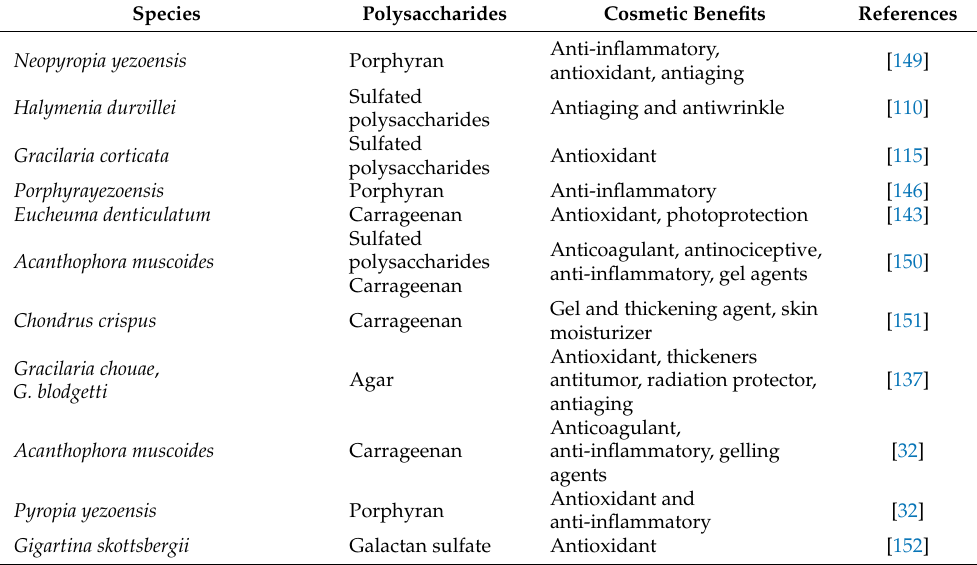
Figure 9. ( a ) agarophyte ( Gracilaria sp.) and ( b ) caragenophyte ( Eucheume spp.) from Indonesia. Table 5. Polysaccharides from red